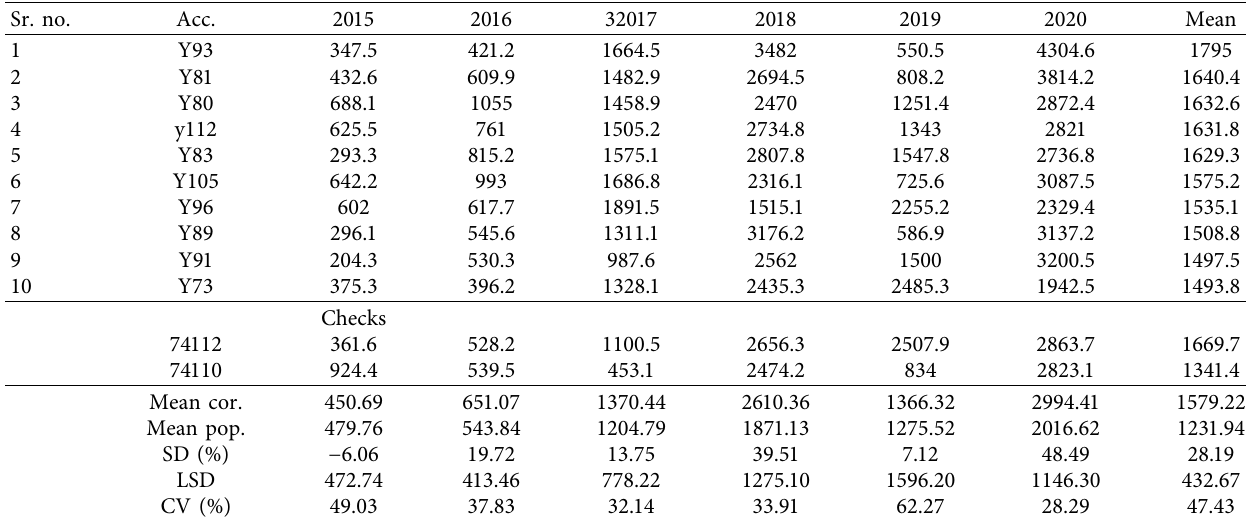
Table 9: List of 10 top high yielder accessions of